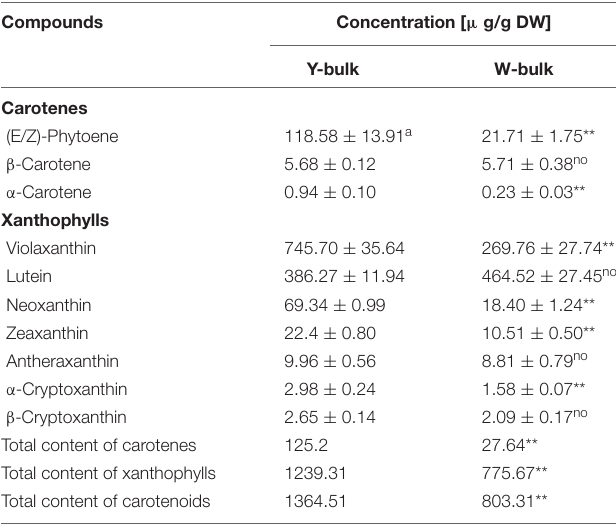
TABLE 2 | Carotenoid contents and compositions in Y-bulk and W-bulk after